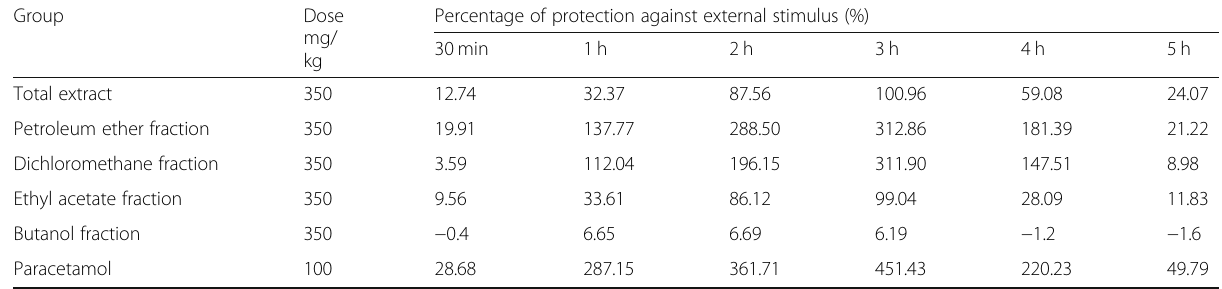
Table 8 Results representing the percentage of protection against external stimulus of the total ethanol extract and the different fractions of C. myxa L. leaves using paracetamol as a standard Group Dose